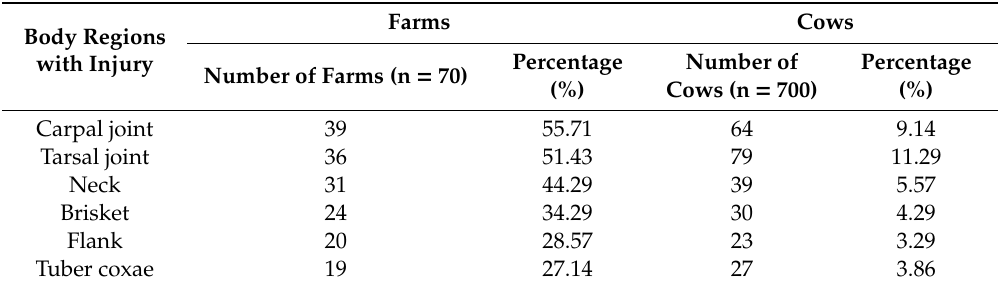
Table 4. Prevalence of lesions on various parts of the body of 700 cows examined in 70 dairy units evaluated for welfare of dairy cattle in the Sirajgonj district, Bangladesh